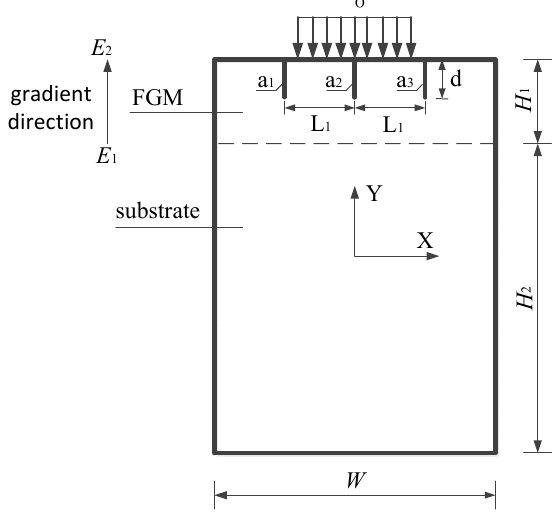
Figure 7. Specimen geometric and boundary conditions.